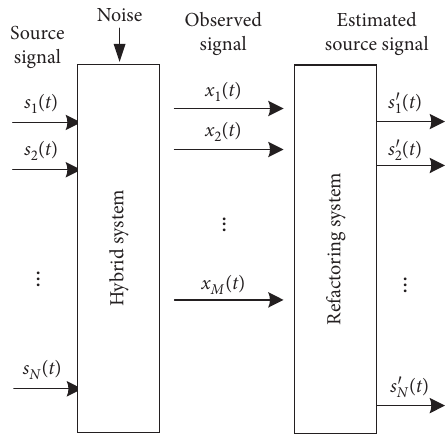
Figure 1: Model of underdetermined